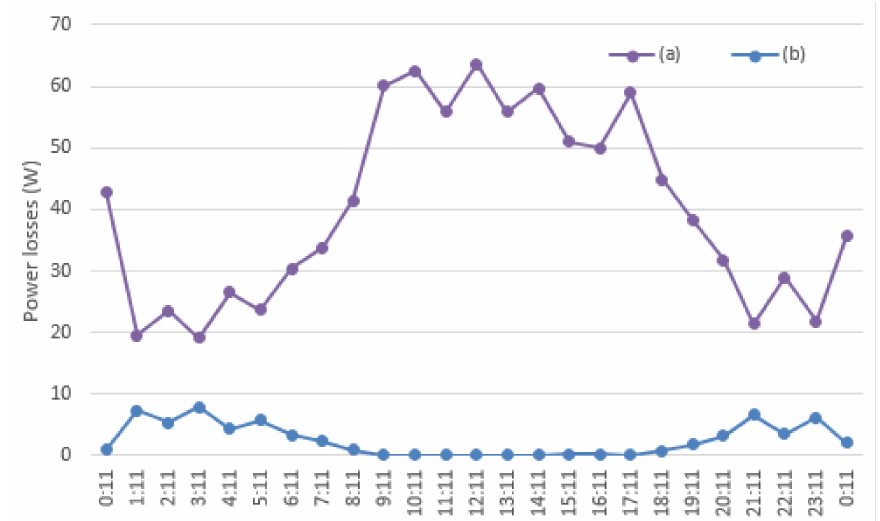
Figure 12. Transformer power losses, on holidays, due to: ( a ) actual reactive currents with non- optimized capacitors; and ( b ) reactive currents with capacitors optimized.